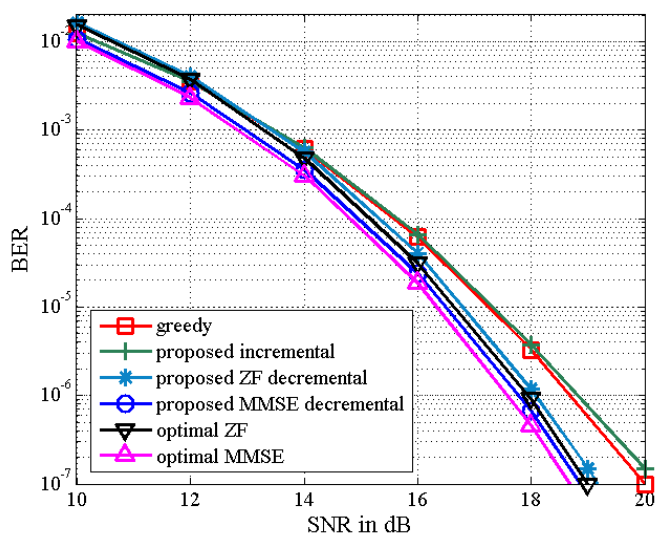
Figure 3. Bit error rate (BER) of the proposed TAS selection algorithm and optimal selection algorithm for (8,4,4) MU–STLC system.